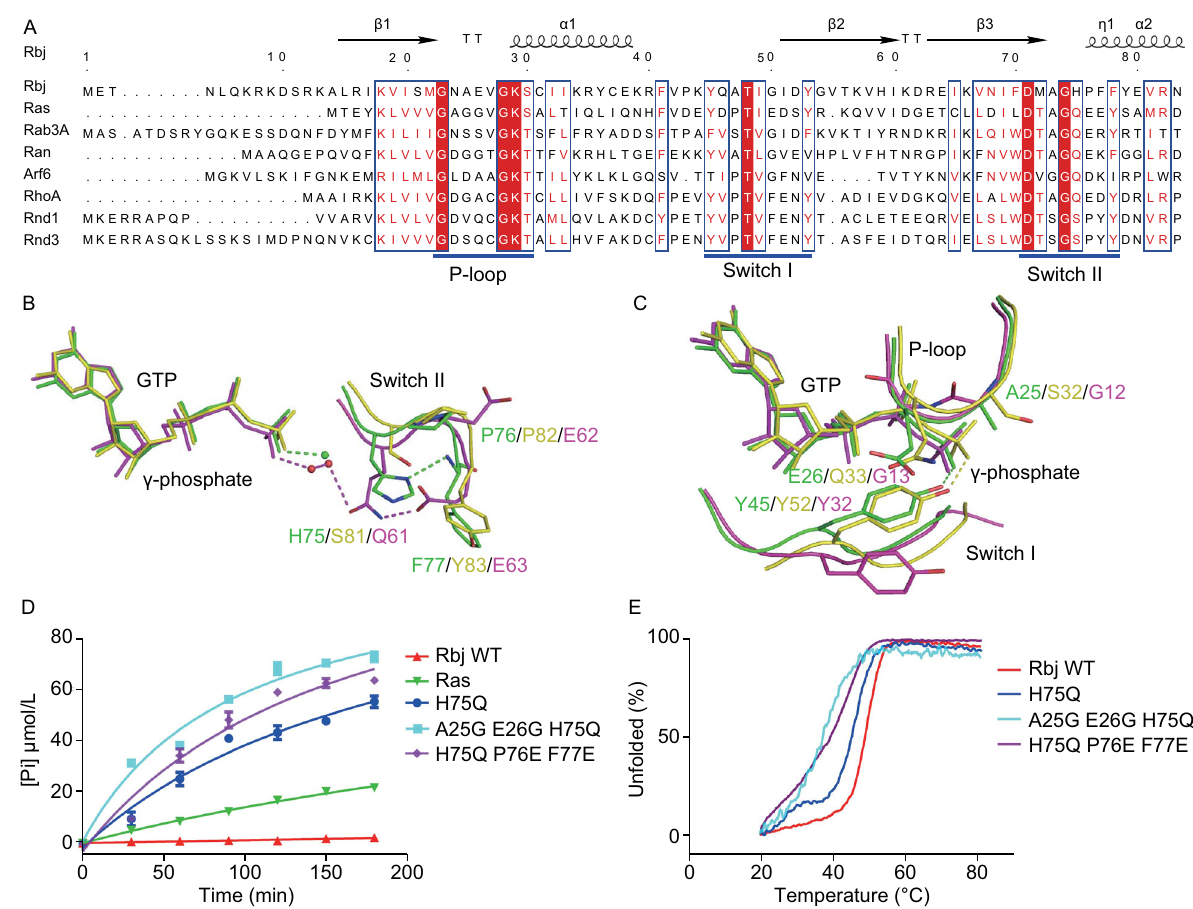
Figure 2. The structural and functional analysis of GTP binding sites . (A) Sequence alignment of the GTP binding sites among representative members of six small GTPase families, with hydrolysis activity (Ras, Rab3A, Ran, Arf6, RhoA) and without activity (Rnd1, Rnd3). The highly conserved amino acids are marked in red. Three GTP binding motifs (P-loop, switch I loop and switch II loop) are highlighted in the blue bar below the sequence. Database sequence accession numbers: Rbj (Q72YF1), Ras (P01112), Rab3A (P20336), Ran (P62826), Arf6 (P62330), RhoA (P61586), Rnd1 (Q92730), Rnd3 (P61587). (B) The structural alignment of key residues on the switch II loop among xRbj (green), Ras (magenta) and Rnd3 (yellow). The amino acids and GTP are displayed in stick format, while the switch loop is displayed in cartoon format. (C) Structural alignment of key residues on the P-loop and switch I loop among xRbj (green), Ras (magenta) and Rnd3 (yellow). The amino acids and GTP are displayed in sticks format, while the loops are shown in cartoon format. The PBD for xRbj, Ras and Rnd3 are 6JMG, 1QRA and 1M7B, respectively. (D) Enzyme activities of xRbj wildtype (red), Ras (green), xRbj-H75Q (blue), xRbj-A25GE26GH75Q (cyan) and xRbj-H75QP76EF77E (purple). (E) Thermostability analysis of the xRbj wildtype and three xRbj mutant proteins. The colors are consistent with Fig.